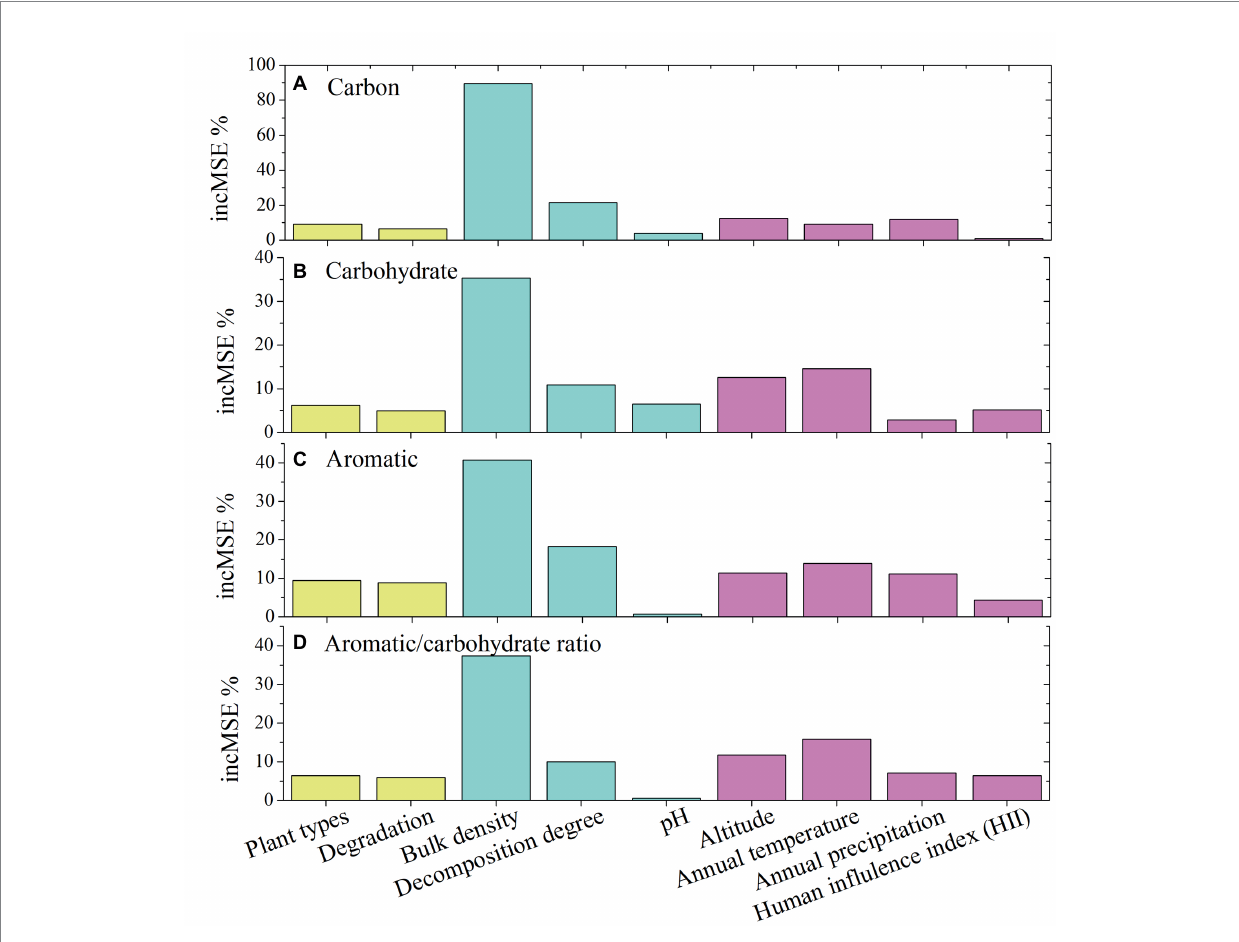
FIGURE 3 Based on random forest analysis, the increase in mean squared error (%IncMSE) of selected environmental factors to carbon contents (A) , carbohydrate contents (B) , aromatic contents (C) , and the ratio of aromatic/carbohydrate (D) .